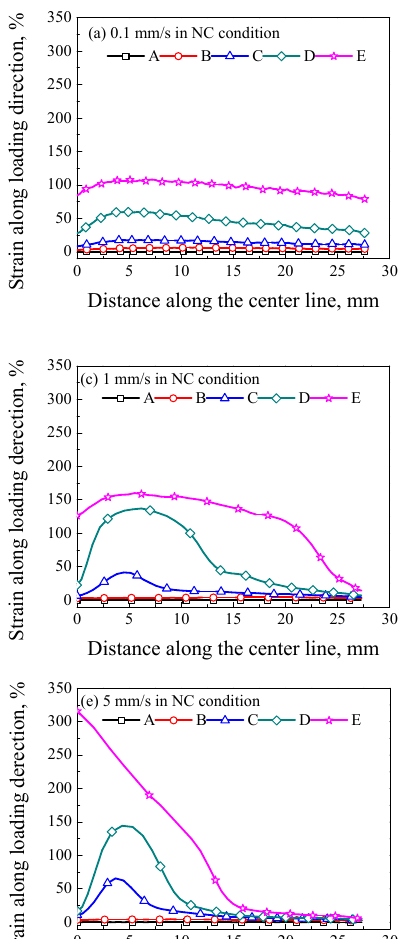
Figure 8. It was found that the maximum temperature change in the FC condition increased with the increasing loading rate, and was less than that in the NC condition at the same loading